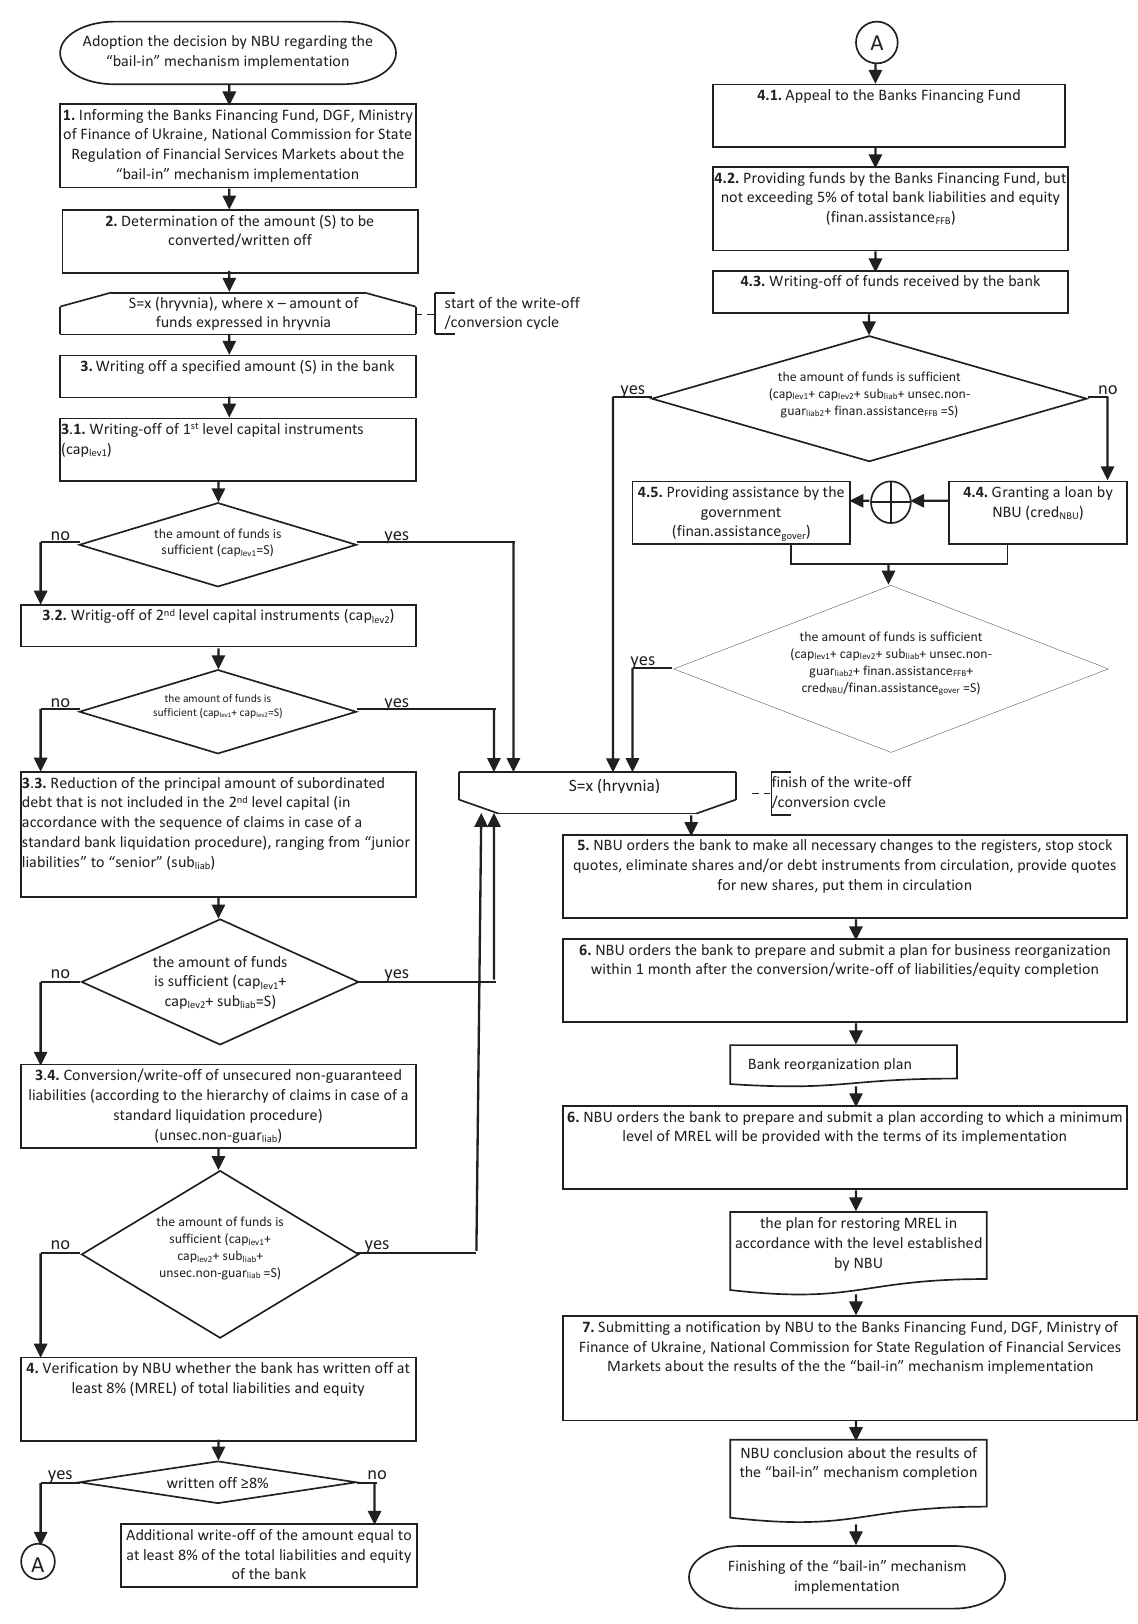
Figure 2. Algorithm for implementation of the “bail-in” mechanism in Ukraine under the condition